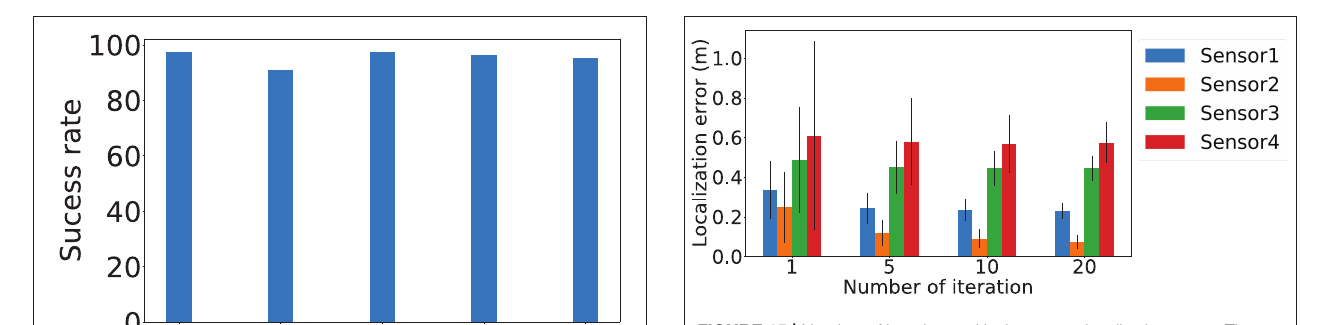
FIGURE 15 | Number of iteration and its impact on localization errors. The x -axis is the number of iterations of estimation used for sensor localization, and y -axis is the localization error. Blue, orange, green, and red bars represent results of Sensor 1, Sensor 2, Sensor 3, and Sensor 4, respectively.